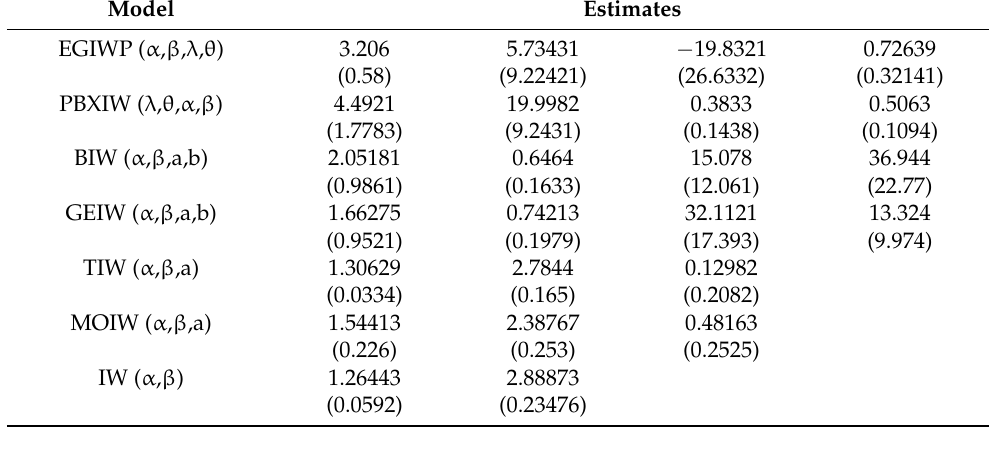
Table 12. MLEs and their standard errors for the 2 nd dataset.